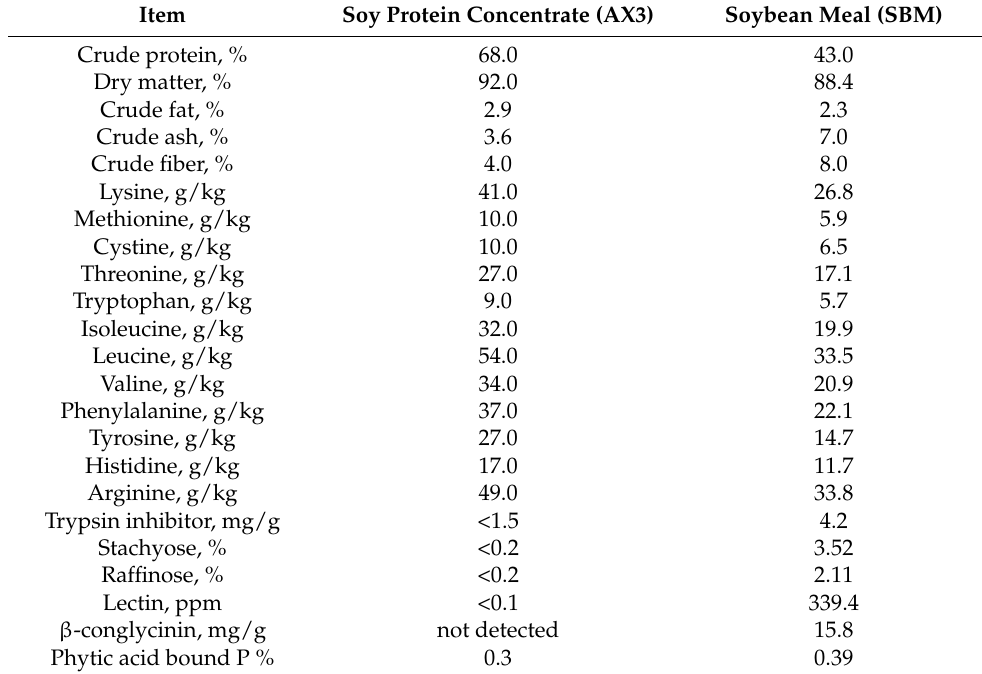
Table 1. Comparison of nutritional quality of soybean meal (SBM) and soy protein concentrate. Item Soy Protein Concentrate (AX3) Soybean Meal (SBM) Crude protein,